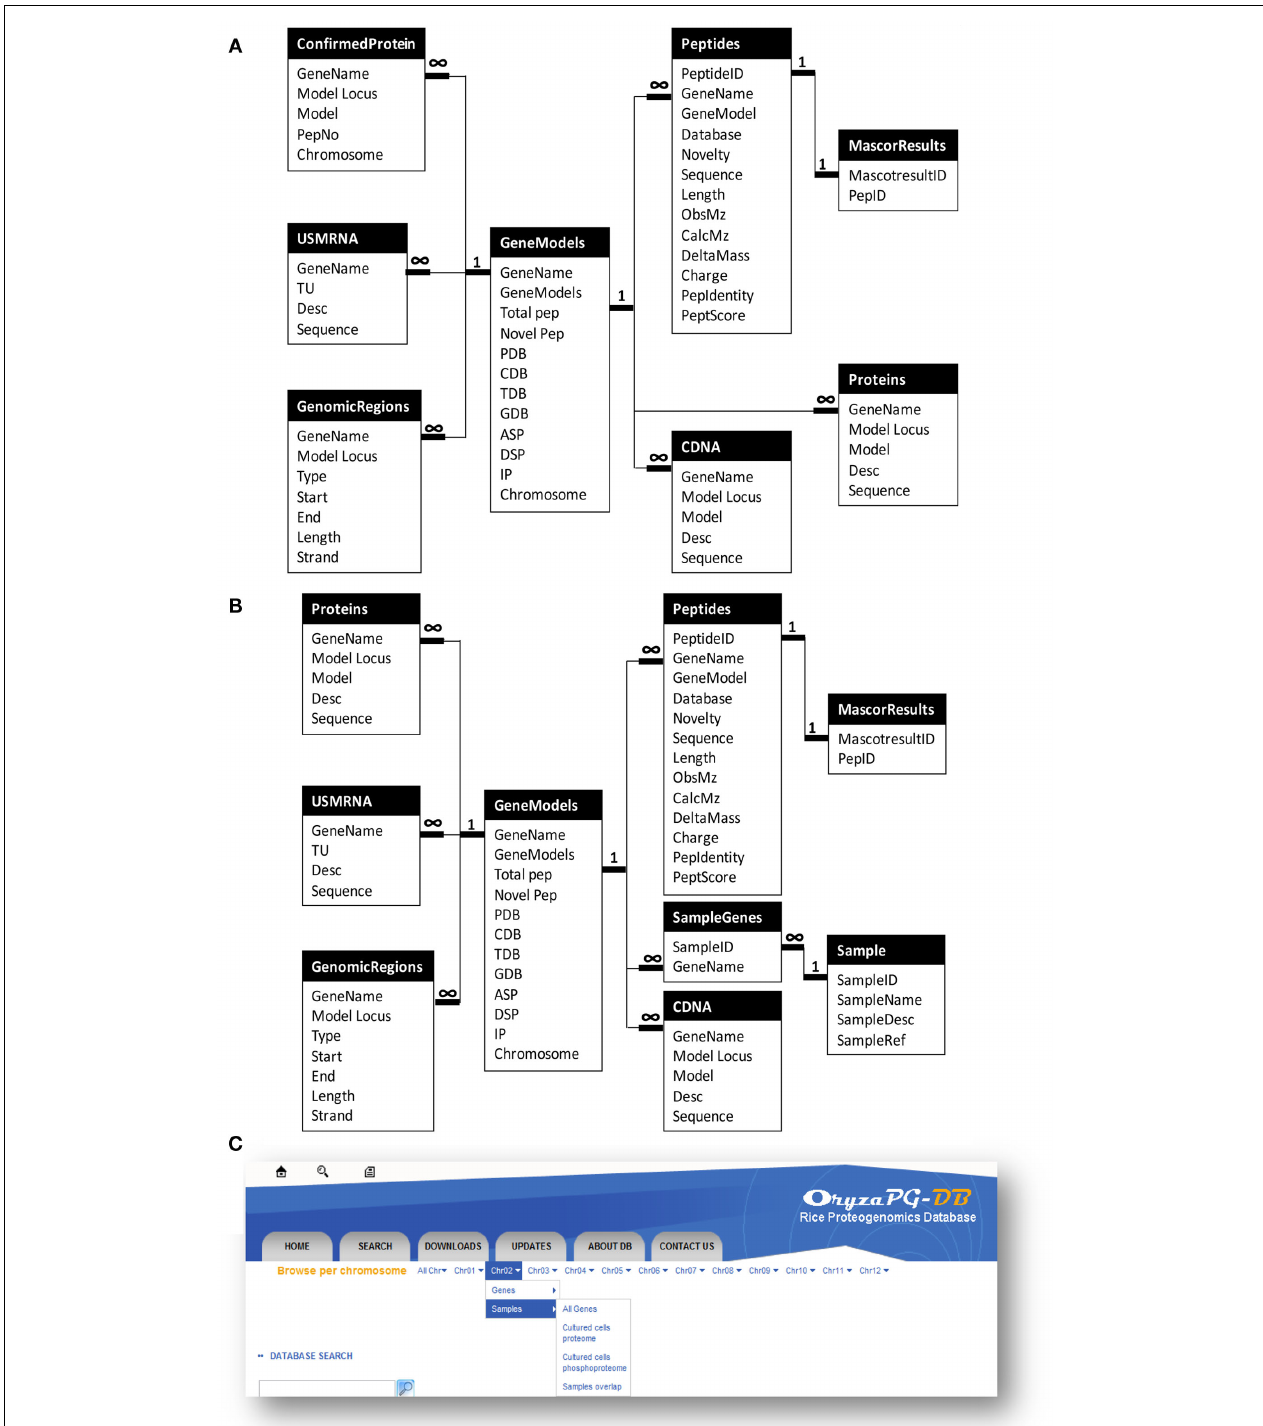
FIGURE 1 | Updated design of OryzaPG-DB and browsing options. (A) OryzaPG-DB original database design adopted from Helmy et al. (2011). (B) OryzaPG-DB (v1.1) database design. (C) Updated database browsing options.